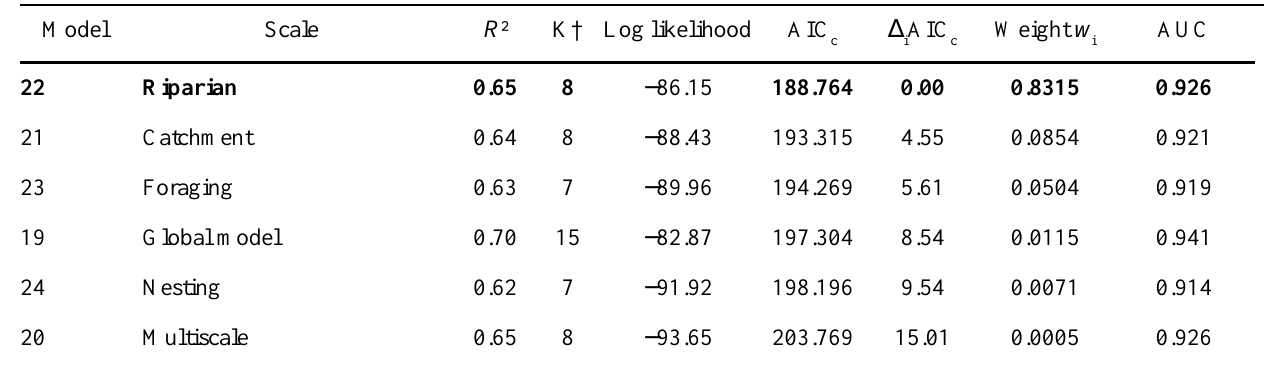
£ 2, are indicated in c